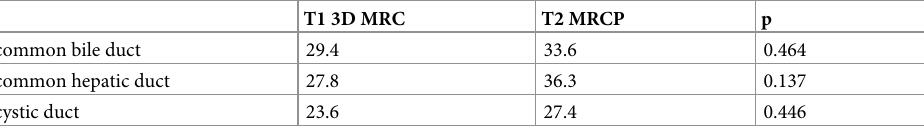
Table 3. Signal-to-noise-ratio of the central bile ducts on T2 MRCP and T1 3D